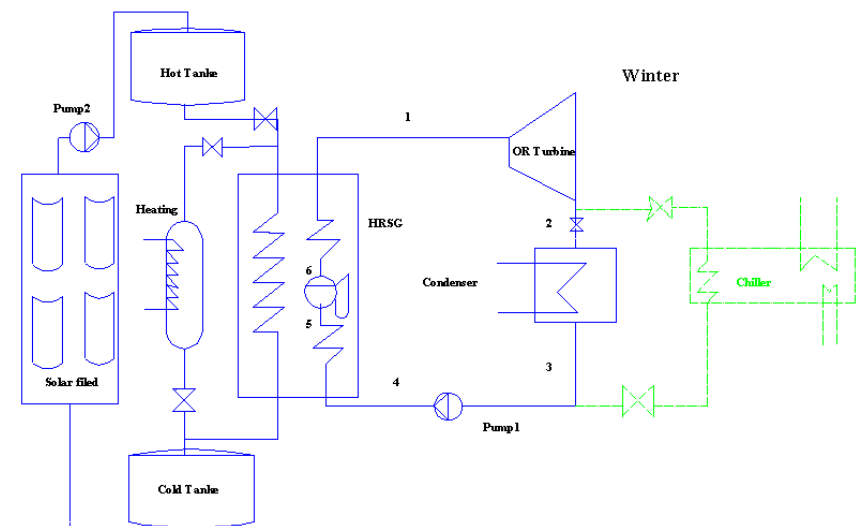
Figure 3. Schematic of the organic cycle combined with solar field in cold seasons in the absence of